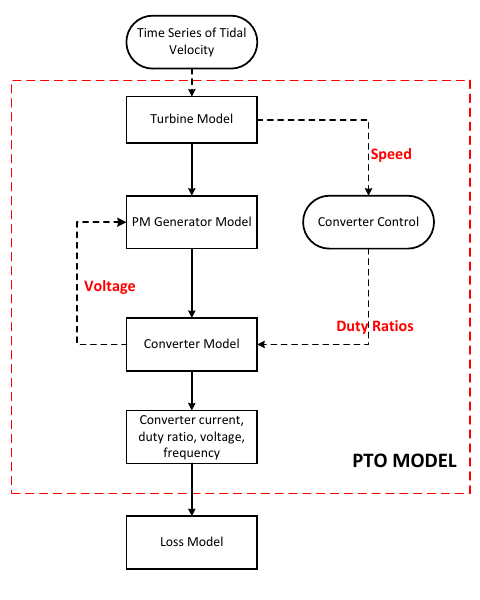
Figure 12. Internal structure of the PTO